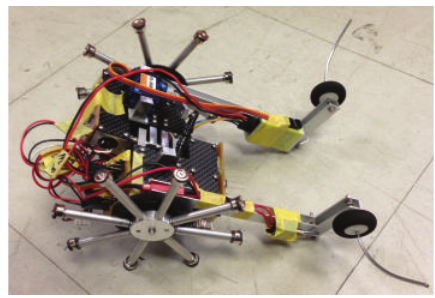
Figure 8: Prototype robot.